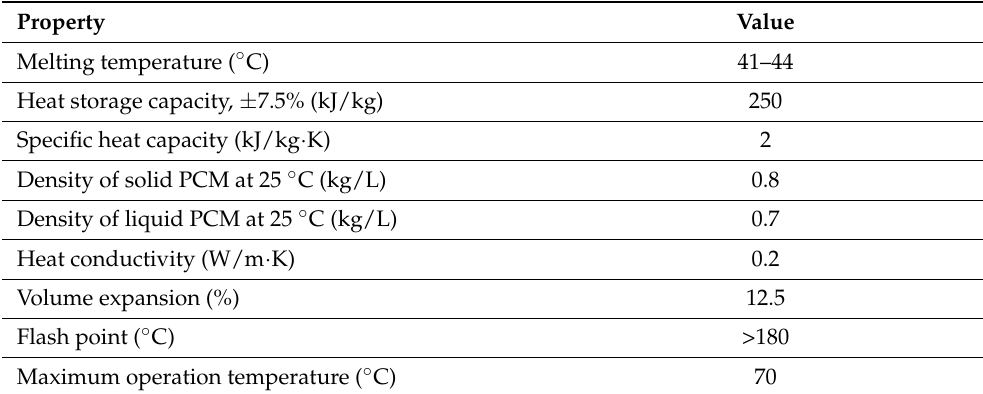
Table 1. Properties of RT44HC phase change material